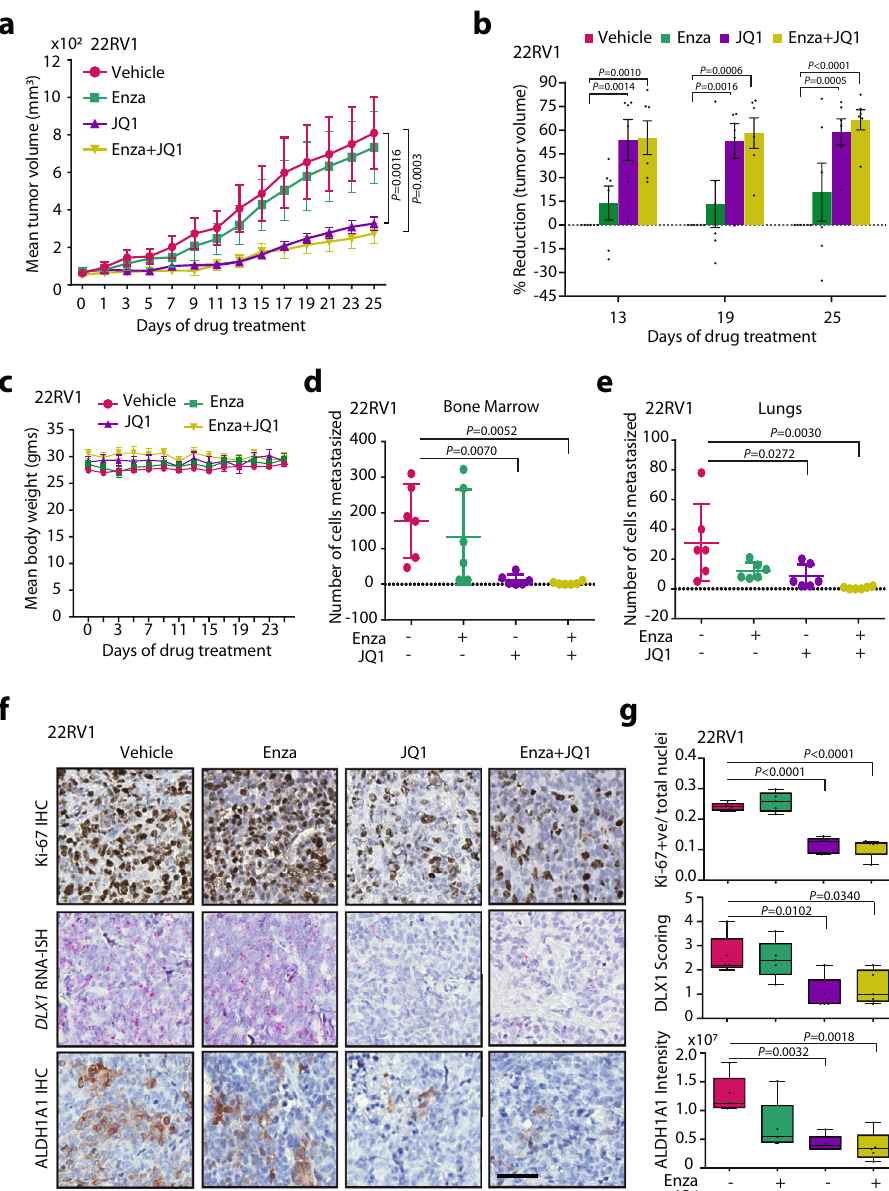
Fig. 8 BET inhibitor alone or in combination with Enzalutamide attenuates DLX1-mediated tumorigenesis and metastases. a Mean tumor volume of xenografts generated by implanting 22RV1 cells in athymic nude mice, and randomized into four treatment groups ( n = 6 each), namely, vehicle control, Enza (20 mg/kg), JQ1 (50 mg/kg), and a combination of Enza and JQ1. b Bar plot showing percent tumor reduction in the treatment groups ( n = 6) compared with the vehicle control group. c Mean body weight of mice ( n = 6 per group) during treated with drugs as mentioned in a . d Scatter dot plot showing number of cells metastasized to the bone in xenografted mice treated with drugs ( n = 6 per group) as mentioned in a . Data represent mean ± SD. e Same as d except cells metastasized to lungs ( n = 6 per group). f Representative images depicting IHC staining for Ki-67, ALDH1A1, and RNA-ISH for DLX1 using formalin- fi xed paraf fi n-embedded tumor xenograft specimens ( n = 5 per group) as a . Scale bar, 50 µ m. g Box plots showing quanti fi cation of Ki- 67, ALDH1A1, and DLX1 expression in the tumor tissue sections ( n = 5) of the mice xenografts as a . Data are presented as box-and-whisker plots indicating median (middle line), 25th and 75th percentile (box), and minimum and maximum values (whiskers). For panels a and b Data represent mean ± SEM. For panels, a two-way ANOVA, Tukey ’ s multiple comparison test; b two-way ANOVA, Dunnett ’ s multiple comparison test; d , e , g one-way ANOVA, Tukey ’ s multiple comparisons test was applied. Source data are provided as a Source Data fi